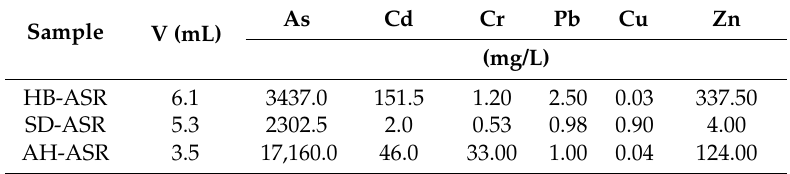
Table 5. Concentration of heavy metals in the hydrothermal fluid of treated ASRs.